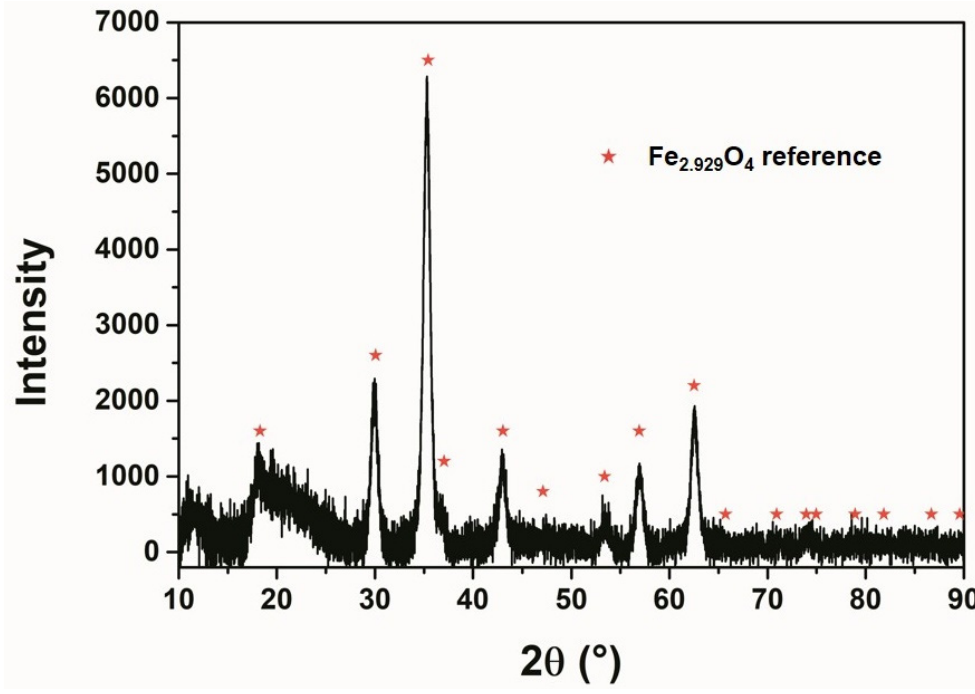
Figure 3. X-ray diffraction (XRD) pattern of the prepared iron oxide